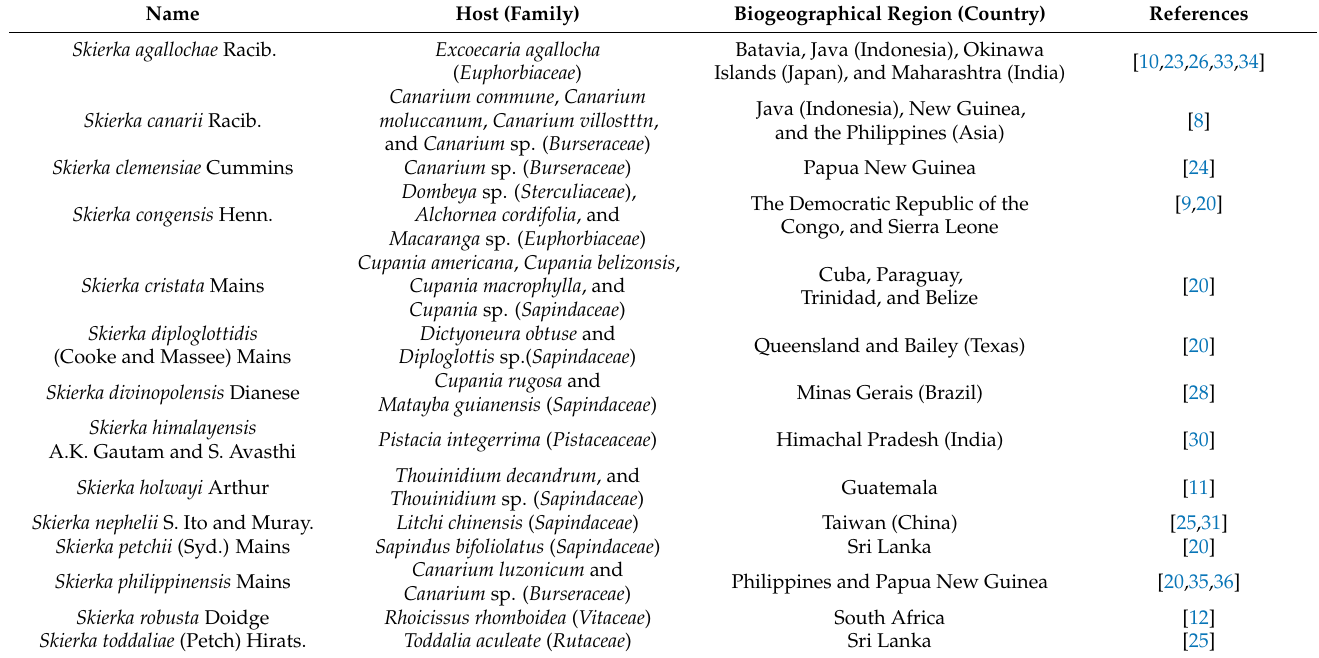
Table 2. List of described Skierka species, together with the host (family), and country of